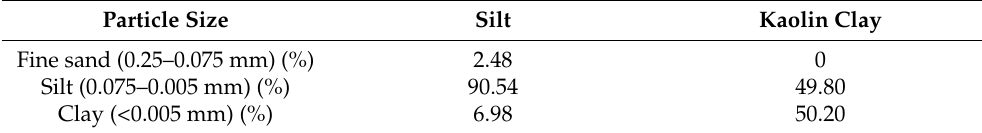
Table 2. Particle size distribution of